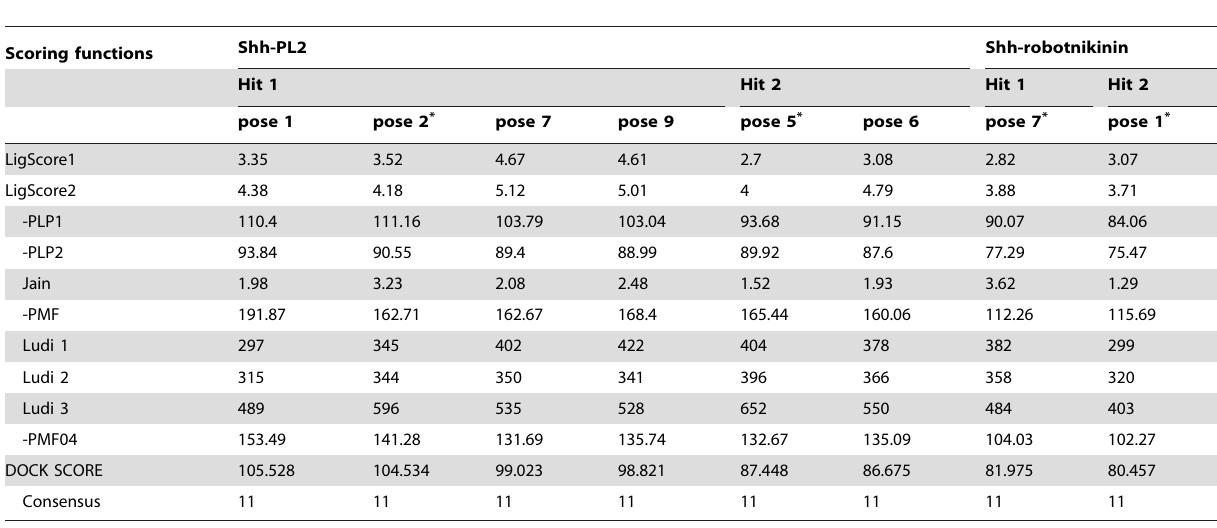
Table 1. Overlapping binding modes of the hit compounds between the Shh-PL2 and Shh-robotnikinin derived pharmacophore models.